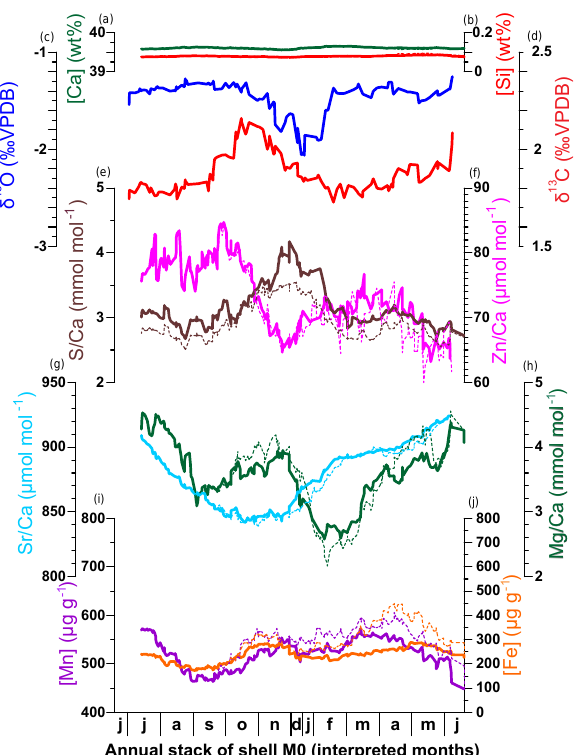
Figure 8. Stack of proxy records for shell M0 made according to a tentative interpretation of annual cyclicity based on δ 18 O and Sr / Ca ratios in Fig. 5. Solid lines indicate annual stacks excluding diagenetically altered samples while dashed lines include all mea- sured samples to show the effect of diagenesis. From top to bot- tom, stacks of Ca (green), Si (red), δ 13 C (red), δ 18 O (blue), S / Ca ratios (brown), Zn / Ca ratios (purple), Sr / Ca ratios (light blue), Mg / Ca (green), Mn (purple) and Fe (orange) records are shown. Subdivisions of the stack into months are based on an interpretation of the phase relationship between the proxies in terms of palaeoen- vironmental seasonality. Note that summer months (December and January) are underrepresented in the record due to the interpreted decrease or cessation of shell